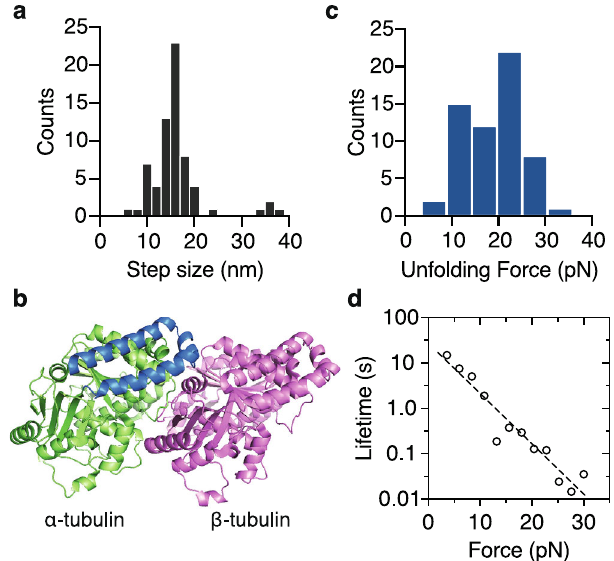
Fig. 4 Characterization of the unfolding events of tubulin during the microtubule-pulling experiments. a The distribution of the unfolding step sizes (16 ± 6 nm; mean ± SD, n = 66 unfolding events). b Structure of αβ - tubulin looking at the microtubule surface (PDB: 3J6F 76 ). The hypothesized unfolding 50 amino acids of α -tubulin is highlighted in blue (Helix 11, 11 ’ , 12). c Distribution of unfolding forces associated with step sizes between 10 and 20 nm (19.2 ± 0.8 pN; mean ± SE, n = 60 events). d Lifetime of the folded state τ as a function of force F transformed from the unfolding force histogram in c (circles). Fit with the Bell equation (dashed line): τ 0 = 25.9